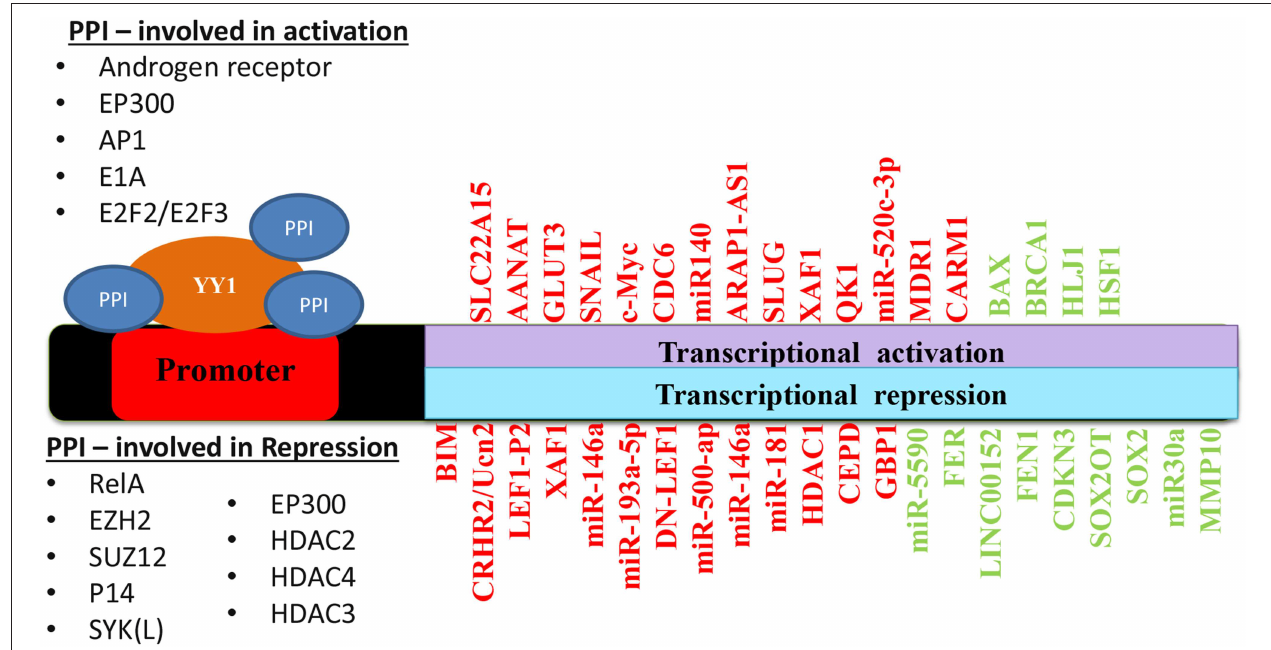
FIGURE 5 | Schematic representation of YY1 protein-protein interactions involved in transcriptional activation and repression of various genes in different cancers. Red color represents an outcome on tumor progression and green color represents tumor suppression.